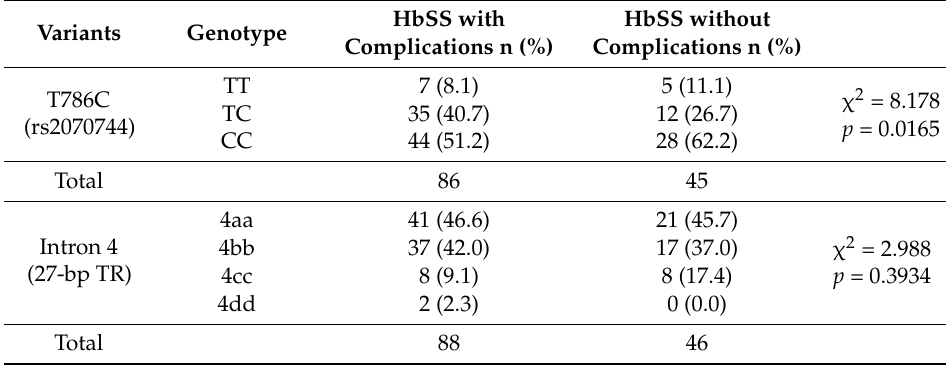
Table 1. Genotypic frequencies for eNOS variants in HbSS patients with complications and those without